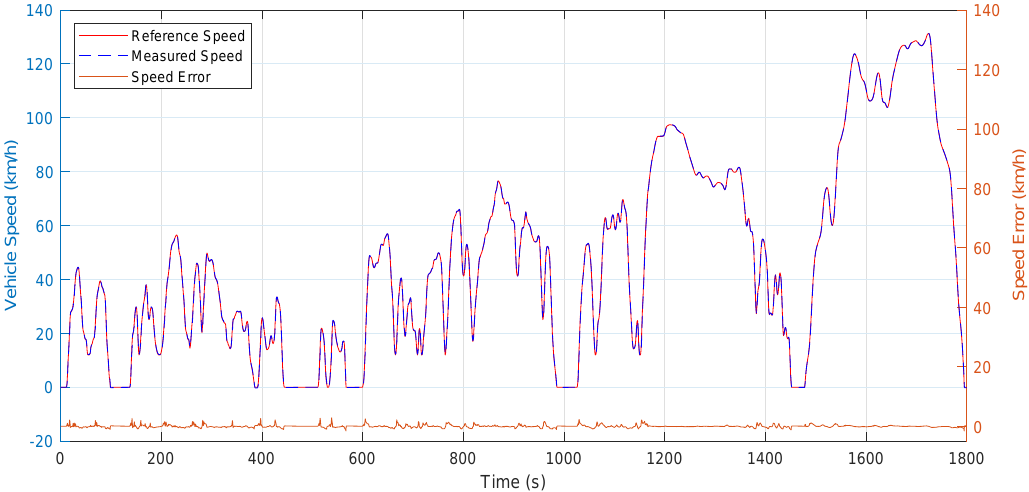
Figure 12. Vehicle reference speed, measured speed, and speed error (with proposed EMS).